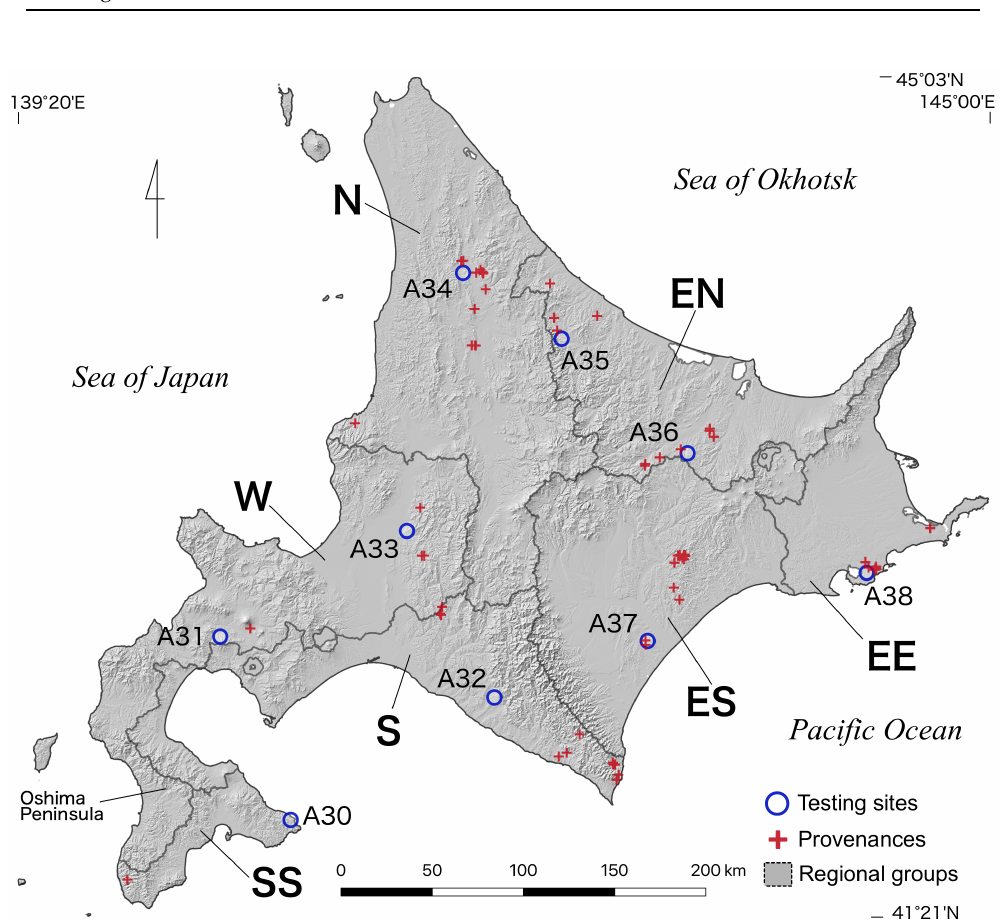
Figure 1. A map of study area showing locations of testing sites, provenances, and regional